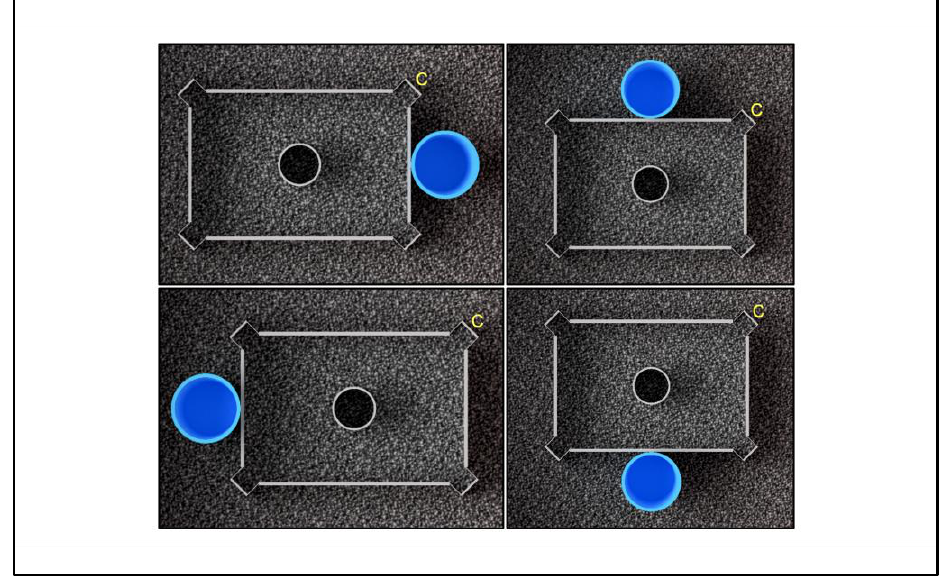
4 of 17 Figure 1. Experimental apparatus. ( a ) Setup from the outside. ( b ) Rectangular transparent arena with upright corridors at the corners. The transparent cylinder hosting the experimental fish at the